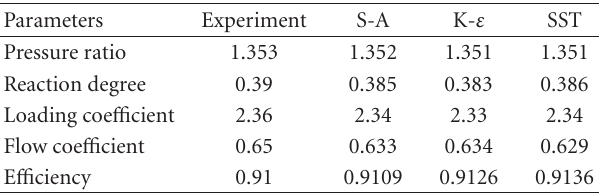
Table 2: Parameters comparison of the 1.5-stage axial turbine